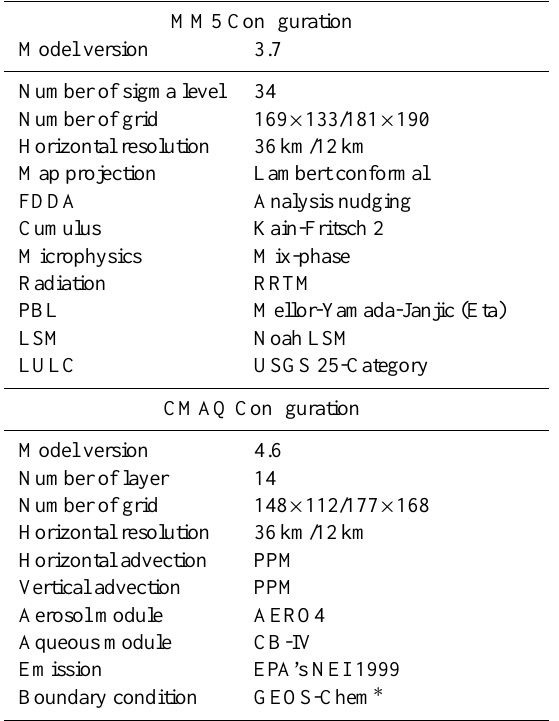
Table 1. MM5 and CMAQ model configurations for present and future simulations.